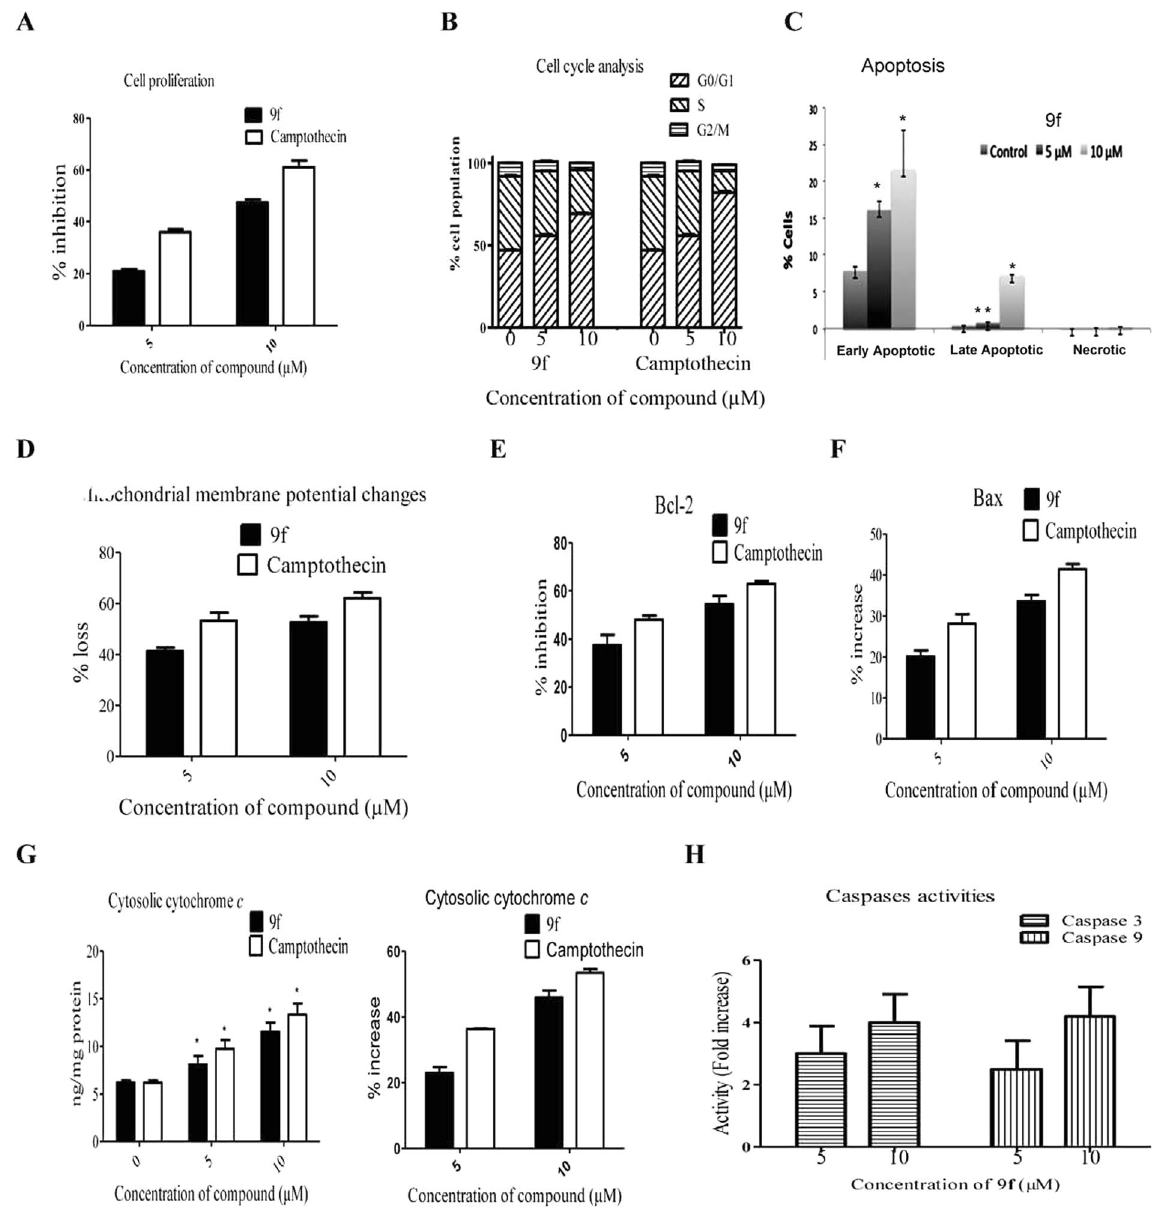
Figure 5. Apoptosis-inducing activity of 9f in MCF-7 breast cancer cells. Panel A: Antiproliferative effect of 9f (5 and 10 µ M) in MCF-7 at 24 h. Panel B: Effect of 9f on cell cycle distribution of MCF-7 cancer cells. Panel C: Apoptotic cell population in 9f treated MCF-7 cells. Panel D: Effect of 9f on mitochondrial membrane potential in MCF-7 cells. Panel E: Effect of 9f on Bcl-2 levels represented in percent inhibition in treated and untreated MCF-7 cancer cells. Panel F: Distribution of Bax levels represented in percent increase in 9f treated MCF-7 cancer cells. Panel G: Effect of 9f in cytosolic cytochrome c levels represented in ng/ml and percent increase in treated and untreated MCF-7 cells. Panel H: Effect of 9f on caspases 3 and 9 activities represented in fold increase in treated MCF-7 cancer cells as compared to untreated. Results of apoptosis-inducing activity of 9f are compared with camptothecin (positive control). Each bar represents mean ± SEM of three independent experiments; * P < 0.05, ** P < 0.01 versus untreated